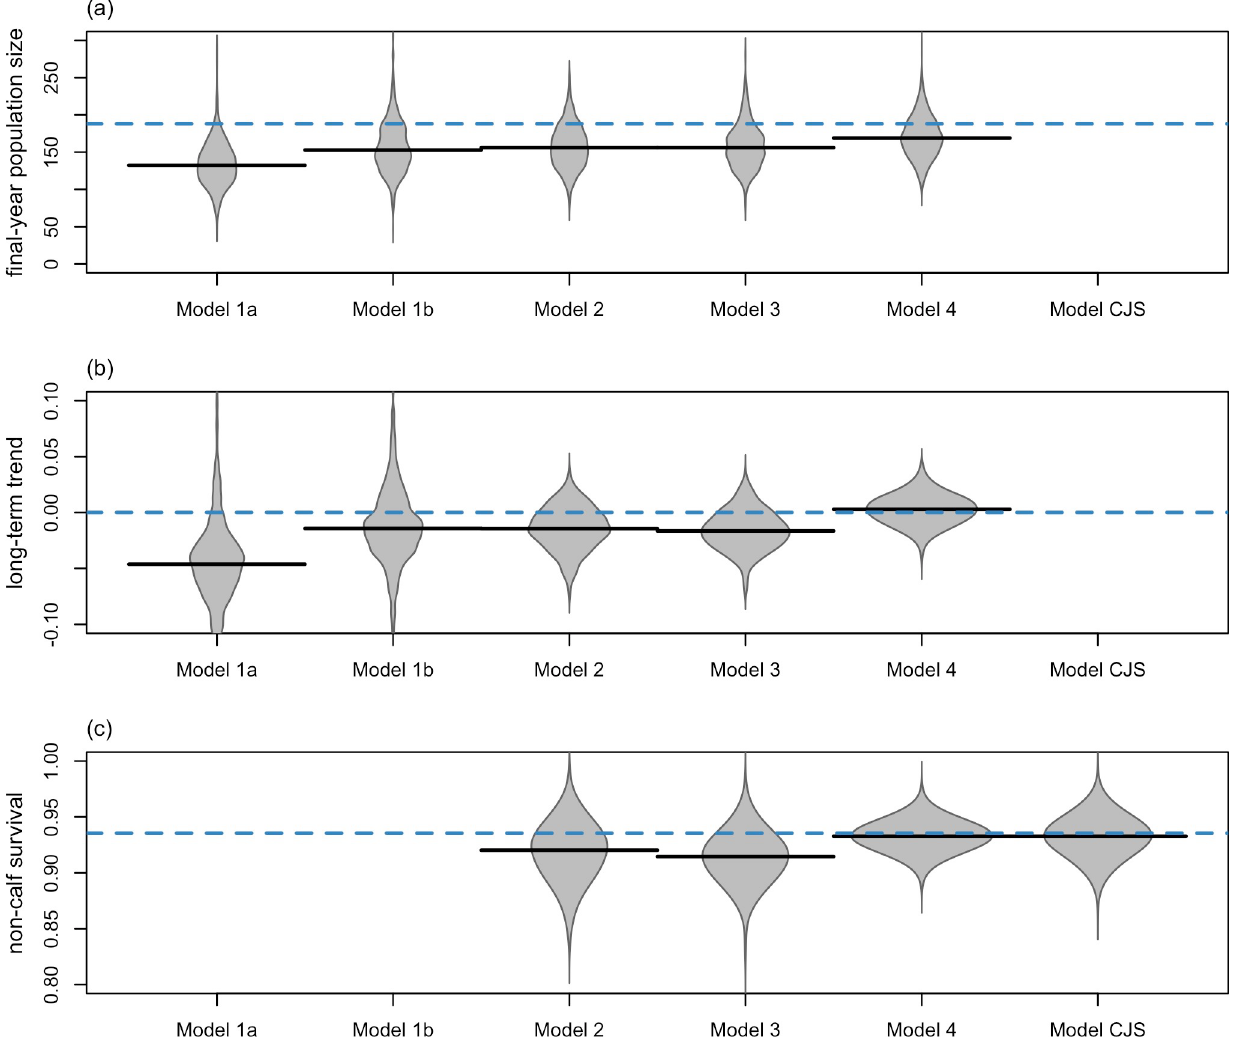
Fig 5. Posterior distributions for (a) final-year population size, (b) long-term trend, and (c) non-calf survival under Scenario B (stable population in shifting habitat). Posterior distributions are shown for Models 1a, 1b, 2, 3, and 4, and a stand-alone CJS model, assuming a stable population. (Non-calf survival is not estimated by Models 1a or b; and final-year population size and long-term trend are not estimated by the CJS model.) In each panel, the blue dashed line indicates the true value, and black horizontal lines indicate the median of the posterior distribution estimated by each model.